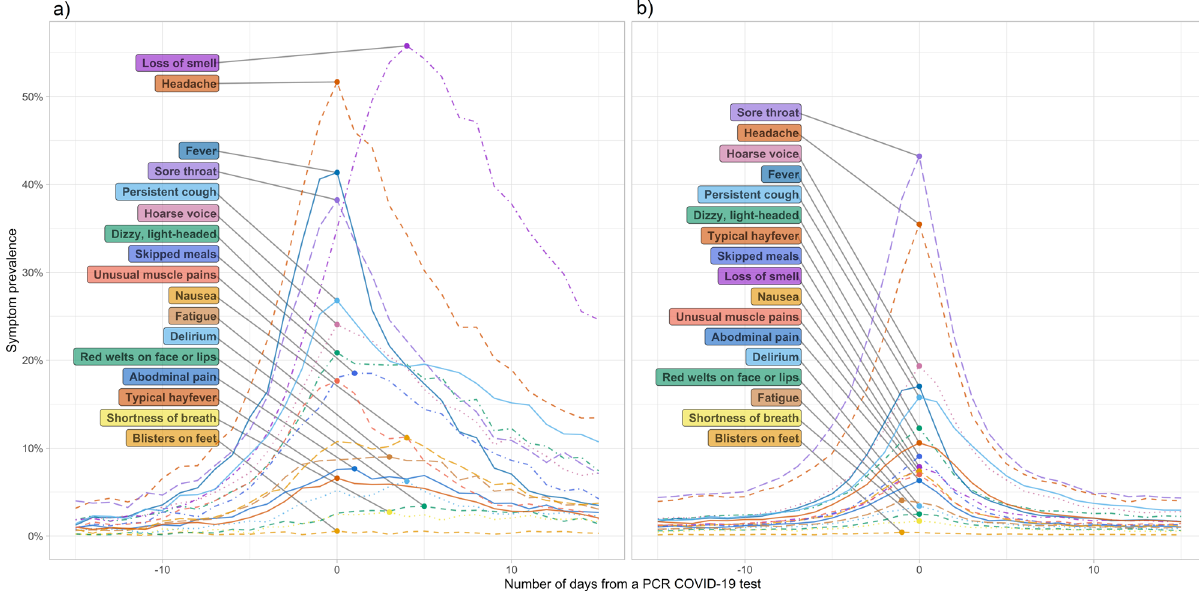
Fig. 1 Symptom trajectories. The prevalence of symptoms reported by participants in COVID Symptom Study Sweden with ( a ) a positive PCR test for COVID-19 (n = 5178), and ( b ) a negative PCR test for COVID-19 ( n = 32,089), across the study period April 29, 2020 – February 10,